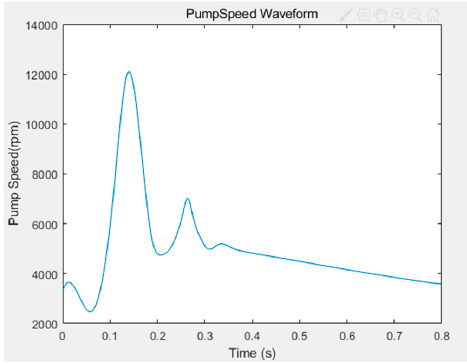
Figure 11. Cavitation bubbles in pump impellers at different speeds: ( a ) ω = 2330 r/min; ( b ) ω = 3330 r/min; ( c ) ω = 4330 r/min.